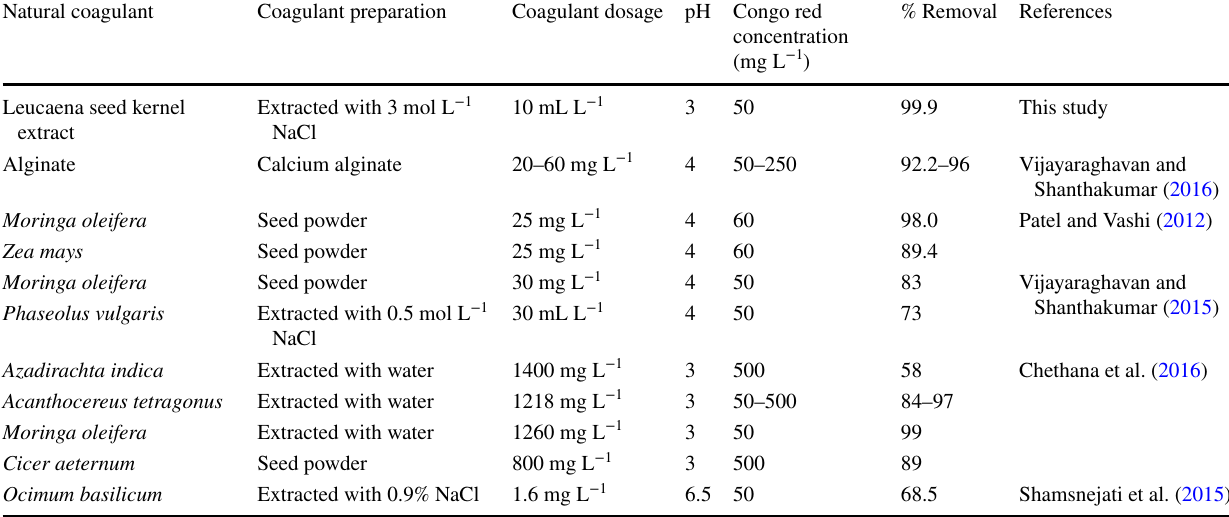
Table 3 Comparison of various natural coagulants in removing Congo red synthetic wastewater Natural coagulant Coagulant preparation Coagulant dosage pH Congo red